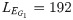
BFADBTagTag cost: Scenarios-1 vs Scenarios-2 (GF(2128), LEG1=192 bits and LMappingSecretKey = 160 bits).